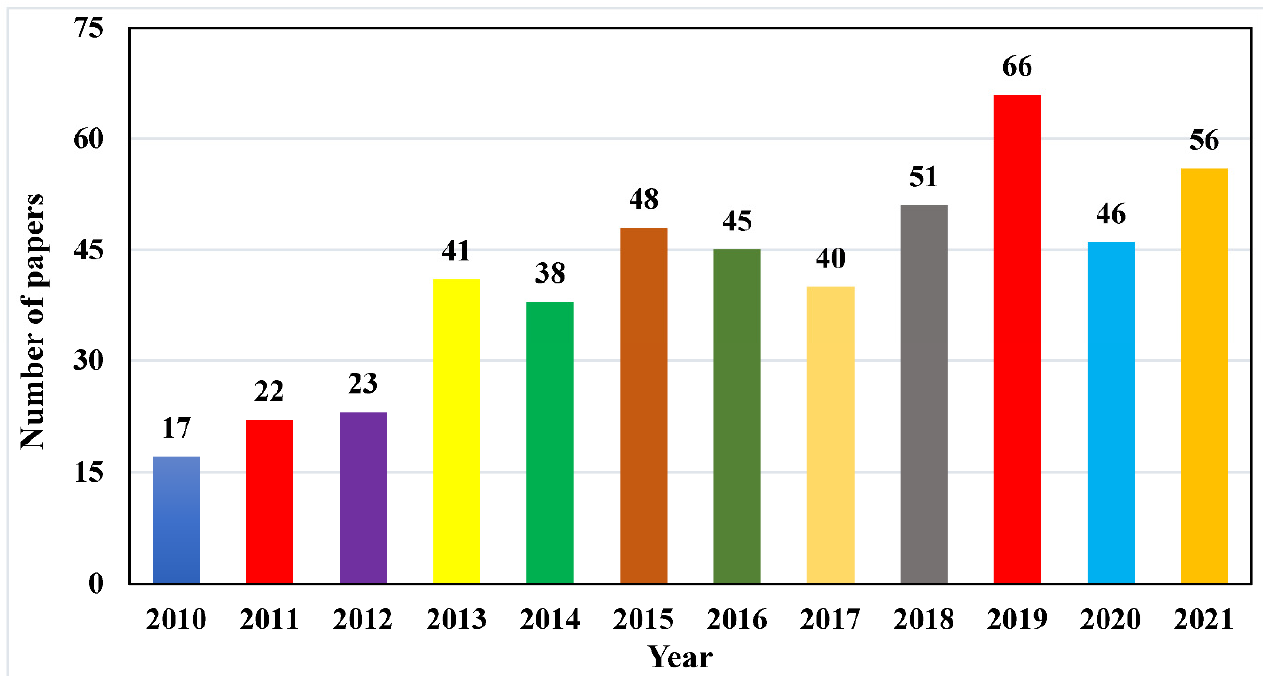
Figure 3. Before scanning the frequency of published manuscripts per year.